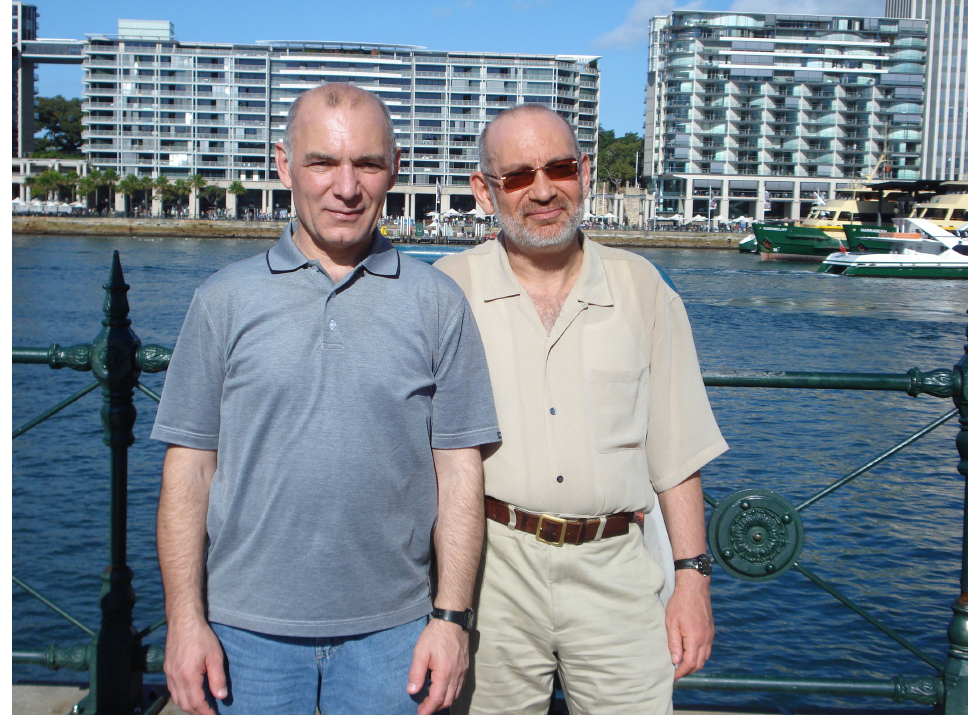
Figure A1. Yury Stepanyants ( left ) and Mikhail Tribelsky ( right ) at the Circular Quay, Sydney, in